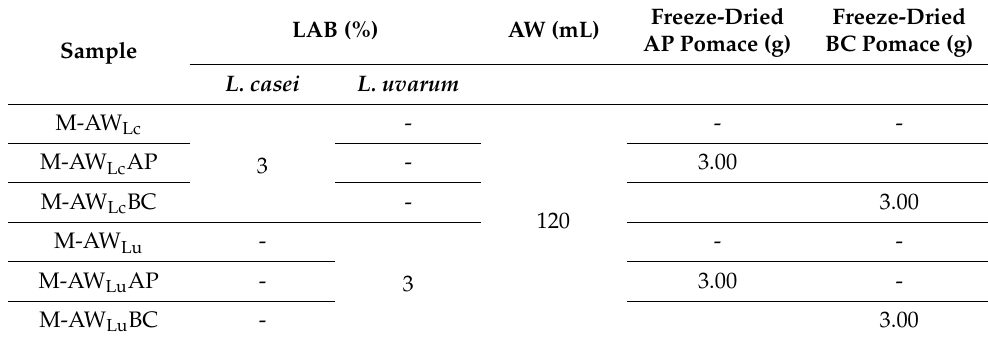
Table 1. The ingredients used for the formulation of the marinades.